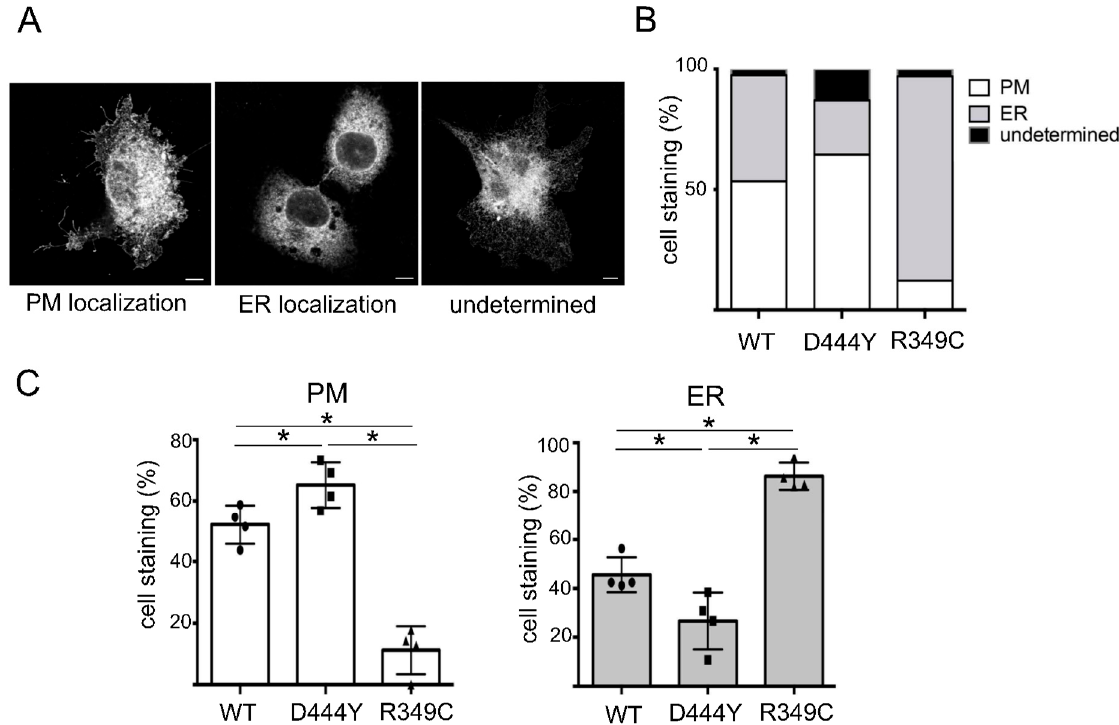
Figure 3. Intracellular localisation of α 3 β 4 nAChRs with a WT or variant ‐ bearing accessory β 4 subunit. ( A ) Representative confocal images illustrating anti ‐β 4 plasma membrane (PM), endoplasmic reticulum (ER) or undetermined staining of NRK cells transfected with DIM plus WT ‐ β 4, D444Y ‐β 4 or R349C ‐β 4 for 48 h at 32 °C. Scale bar: 10 μ m. ( B ) Graph showing the intracellular distribution of nAChRs expressed in NRK cells transfected with DIM plus WT ‐β 4( ● )D444Y ‐β 4, ( ◼ ) or R349C ‐β 4( ▲ ) for 48 h at 32 °C. Three independent experiments involving 116, 93, and 85 cells, respectively. ( C ) Non ‐ parametric t and Mann–Witney tests revealed statistically significant